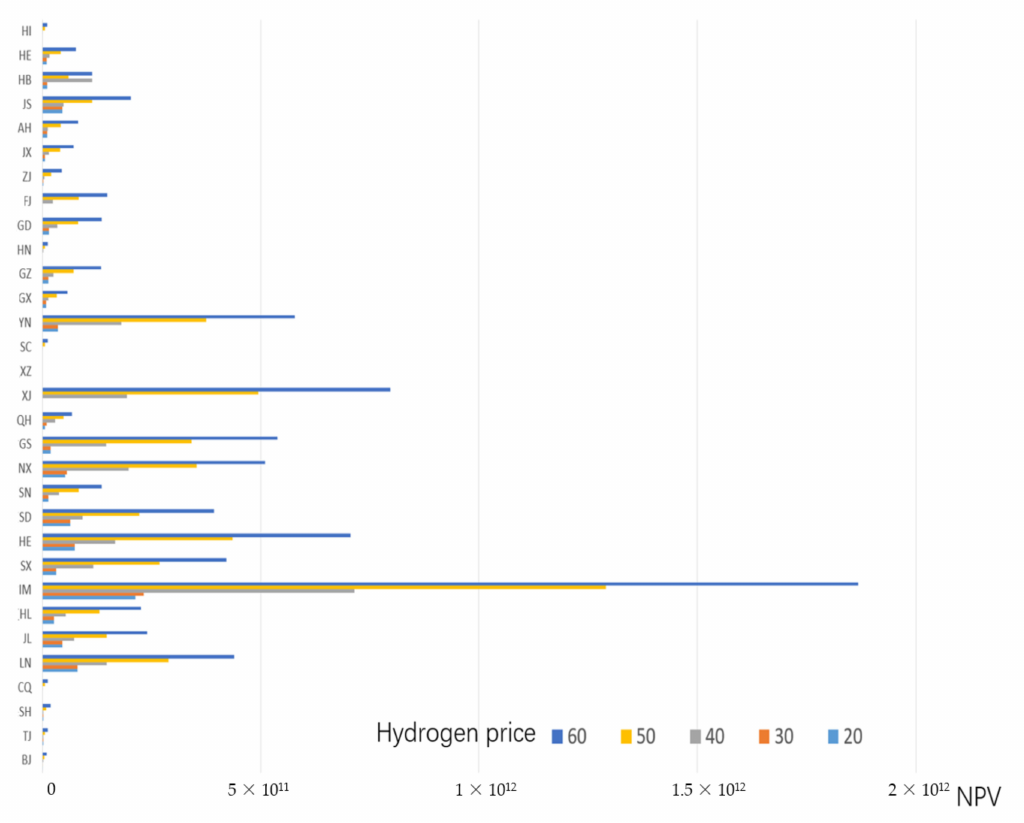
Figure 6. Comparison of NPV